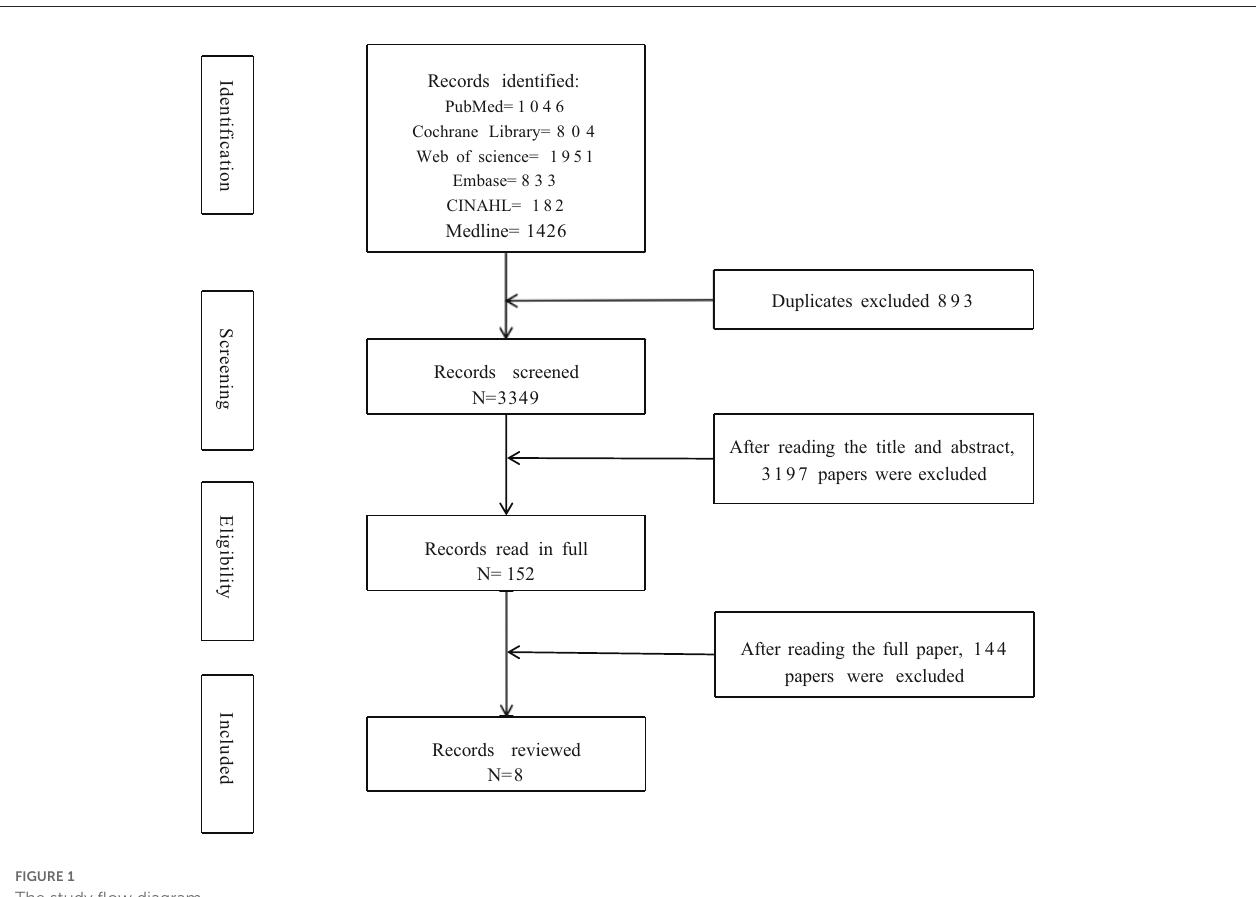
FIGURE1 The study flow